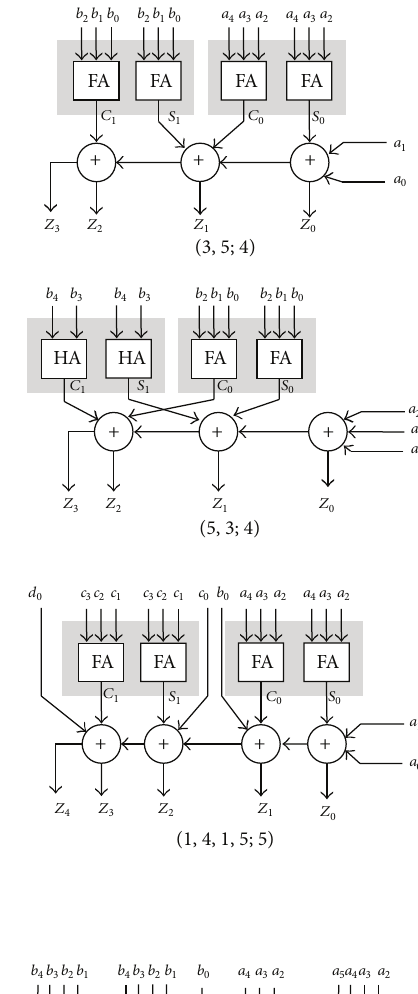
Figure 12: Area optimal mapping for different GPCs using proposed heuristic on Altera FPGAs.